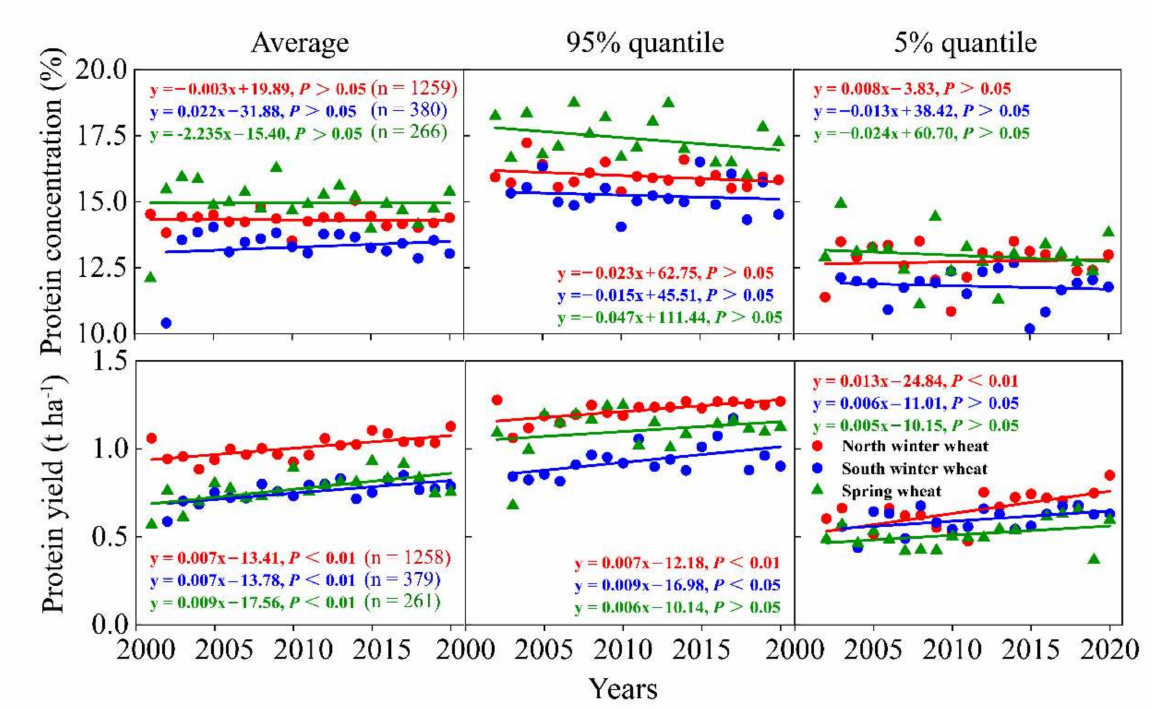
Figure 3. The average value, 95% quantile value, and 5% quantile value of protein concentration, protein yield of wheat varieties released in 2001–2020 for three wheat-growing